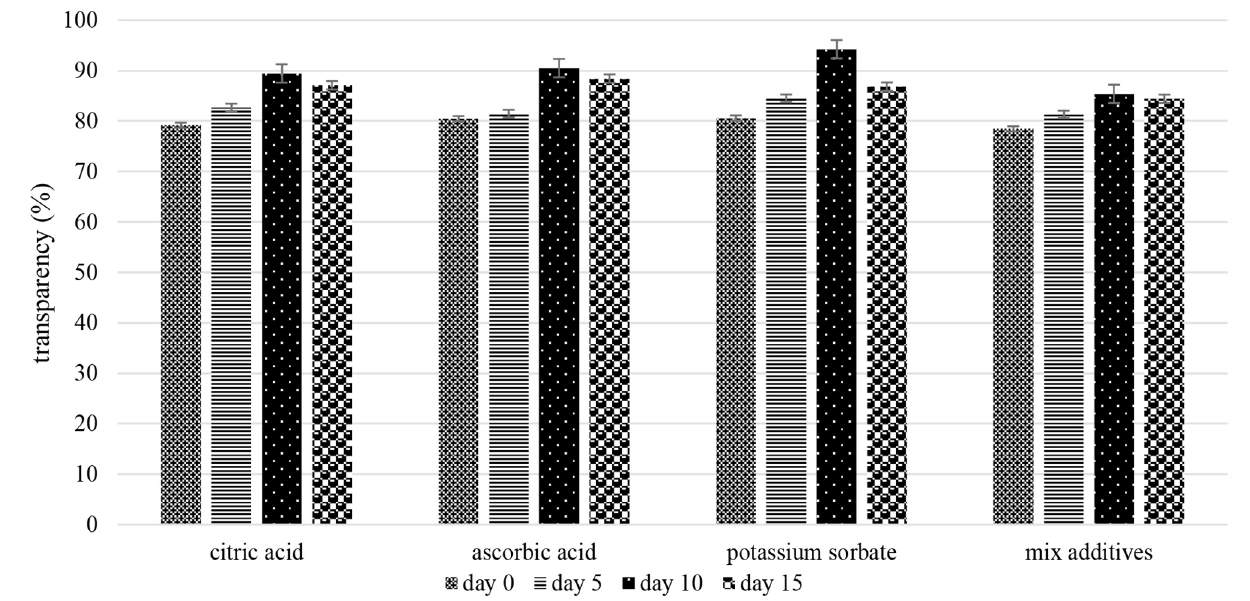
FIGURE 6 | Morphology of AVG coating without additive (A) , AVG coating with mixture of citric acid, ascorbic acid and potassium sorbate additive (B,C) .